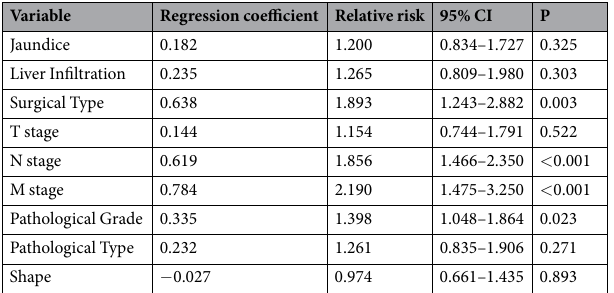
Table 4. Results of Cox multivariate regression